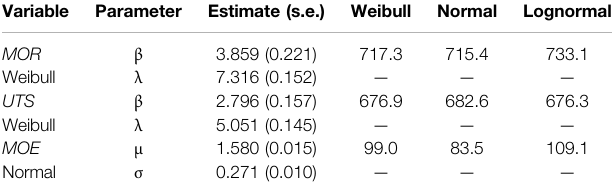
TABLE 2 | The parameter estimates and standard errors for the fi tted Weibull distributions for MOR , UTS , and fi tted normal distribution for MOE . The Weibull density parametrization being used is f Weibull ( x ; β , λ ) (cid:2) βλ − 1 ( x / λ ) β − 1 exp [−( x / λ ) β ] for x > 0. The AIC values for the fi tted Weibull, log- normal, and normal distributions are on the right-hand side.